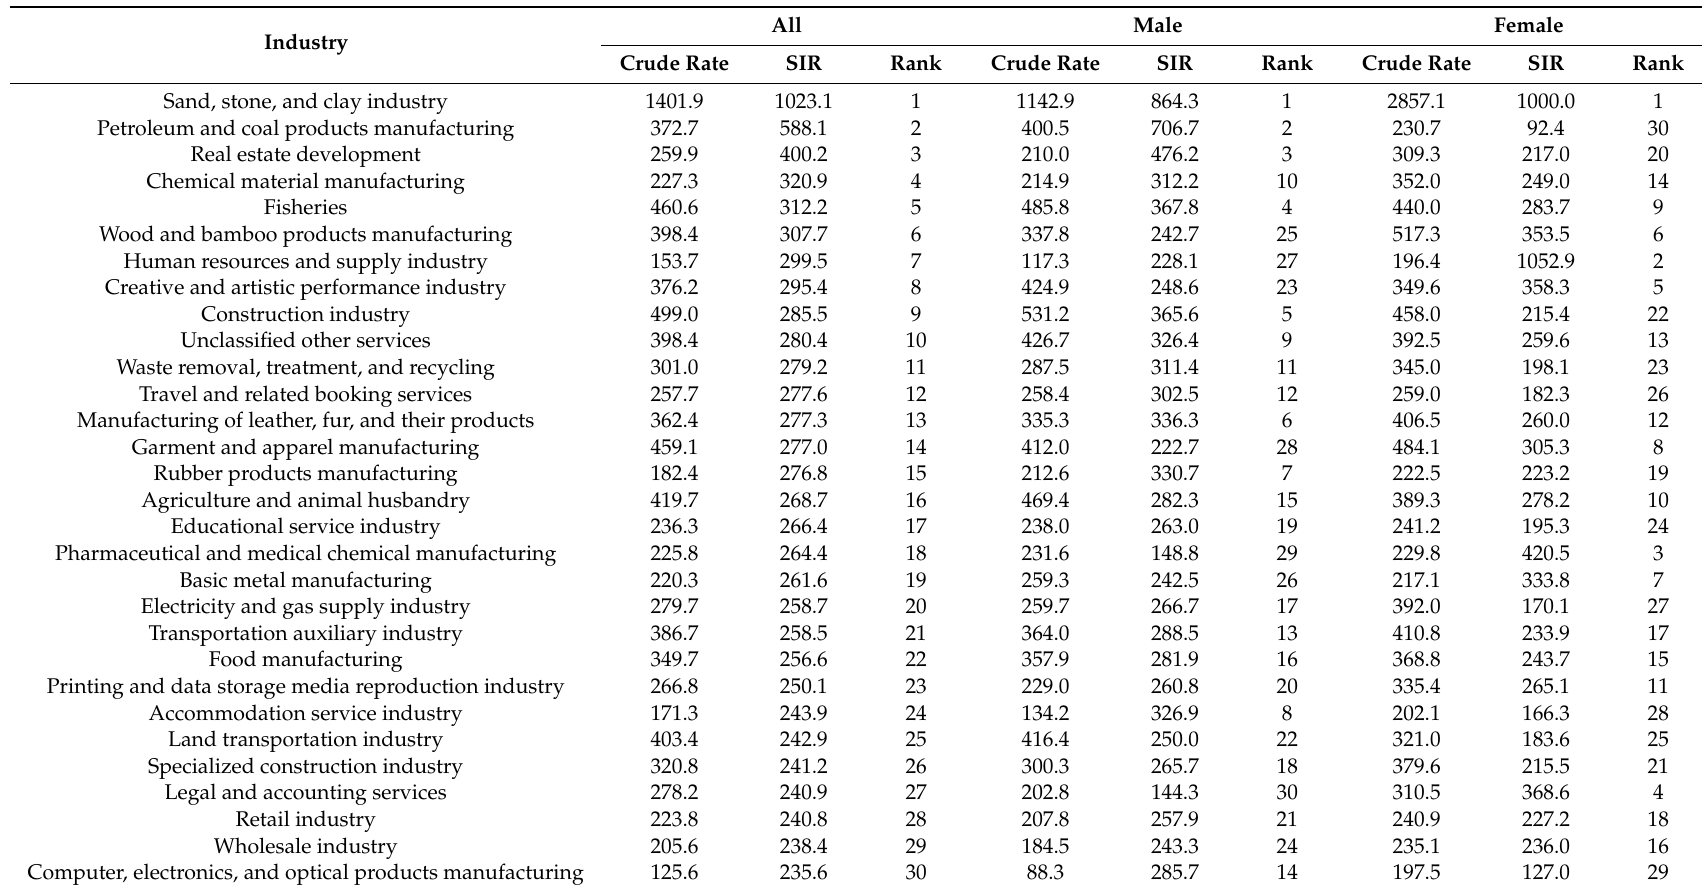
Table 3. Crude rates and direct standardized incidence rates (SIRs) of first-ever cancer diagnosis among insured workers in Taiwan in 2010 in the top thirty industries, stratified by